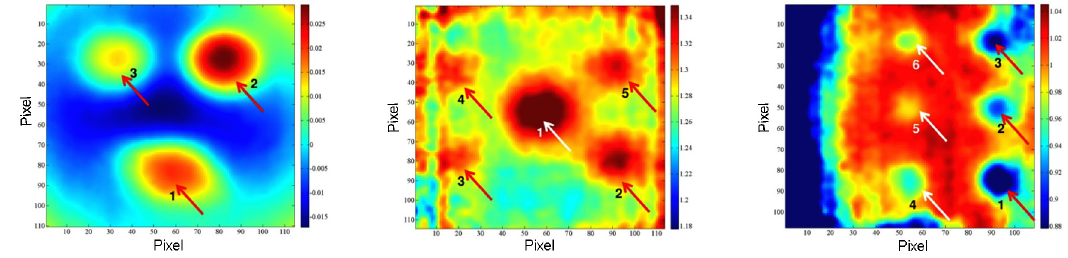
Fig. 6. PCT (EOF 3 ), BM 3-3, bottom surface, distance 1.5 m